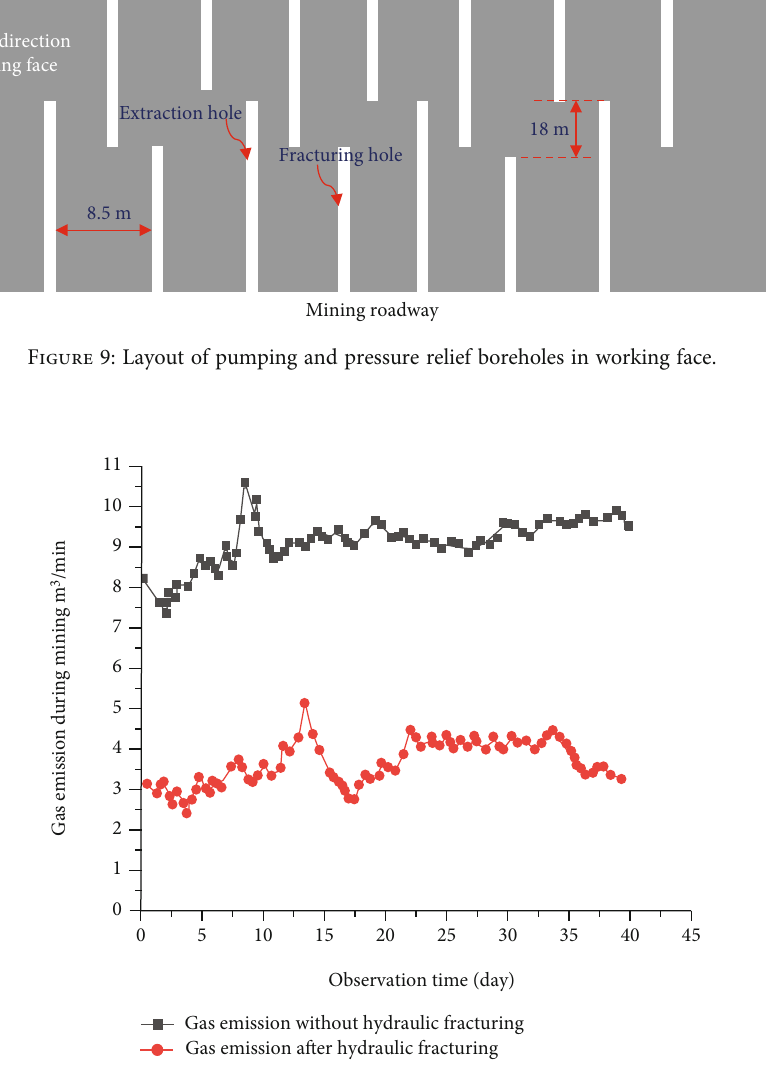
Figure 10: E ff ect of hydraulic fracturing on gas emission from coal face.